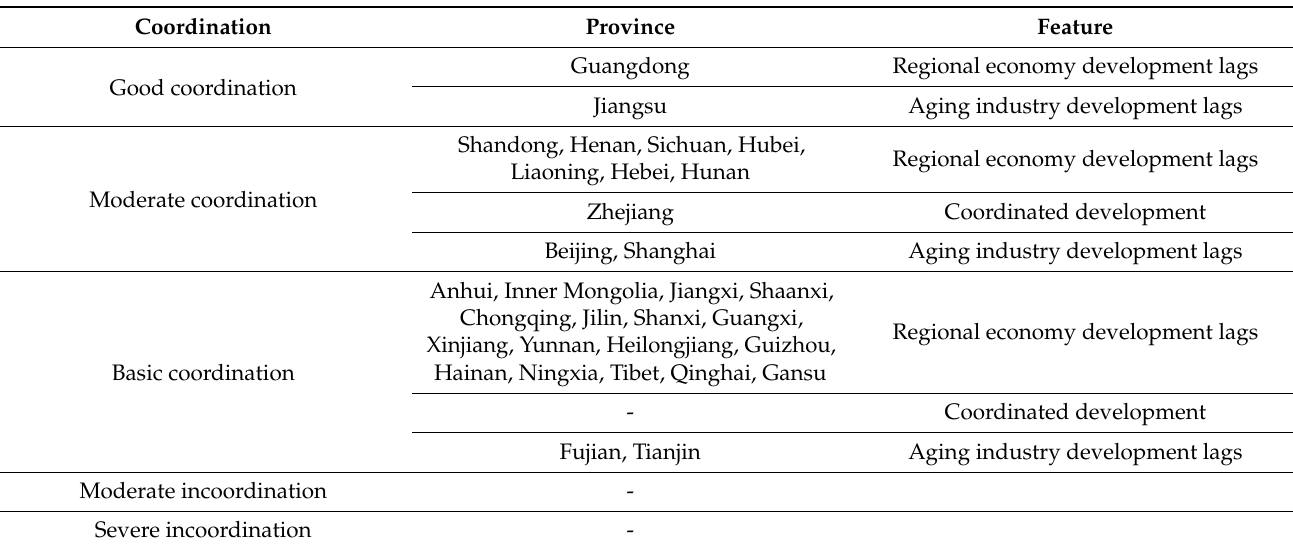
Table 4. Distribution of the mean value of the coupling coordination index between the aging industry and the regional economy in various provinces (2009–2019).